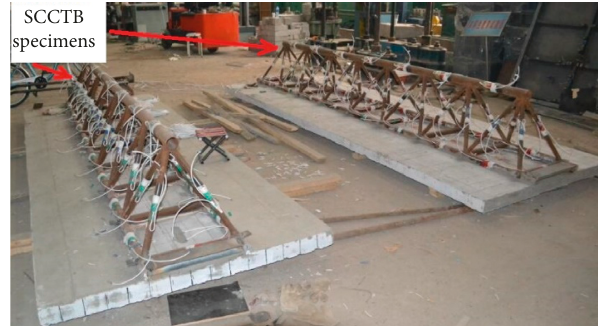
Figure 2: Photograph of the SCCTB